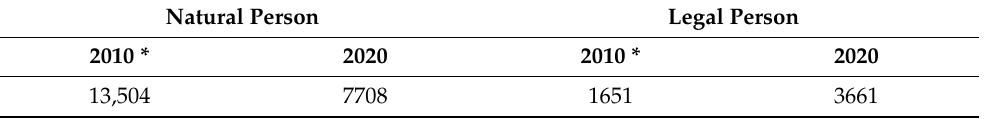
Table 1. Number of agricultural holdings by legal form of holder (source: Statistics Estonia 2021).